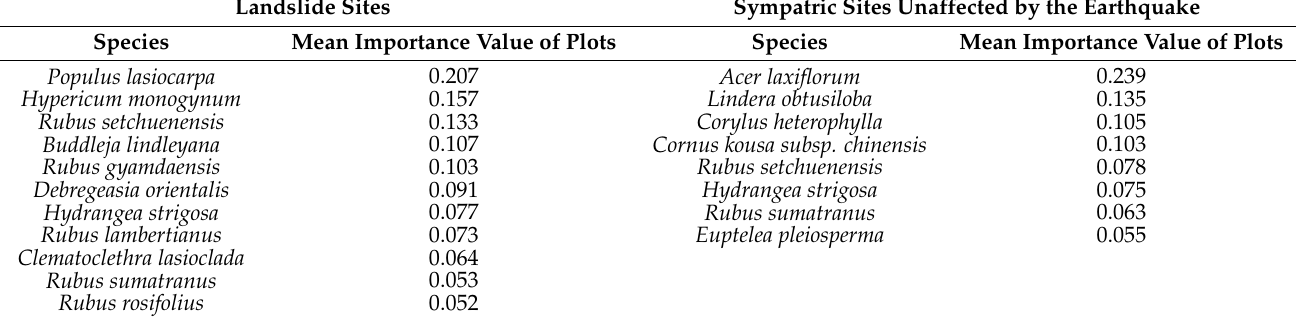
Table 1. Differences of woody plant species between landslide and sympatric sites unaffected by the earthquake. Only data greater than 0.05 are listed